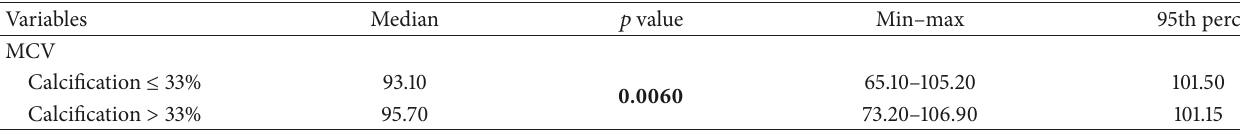
Table 6: Wilcoxon signed-rank test for MCV and MCH excluding females from the